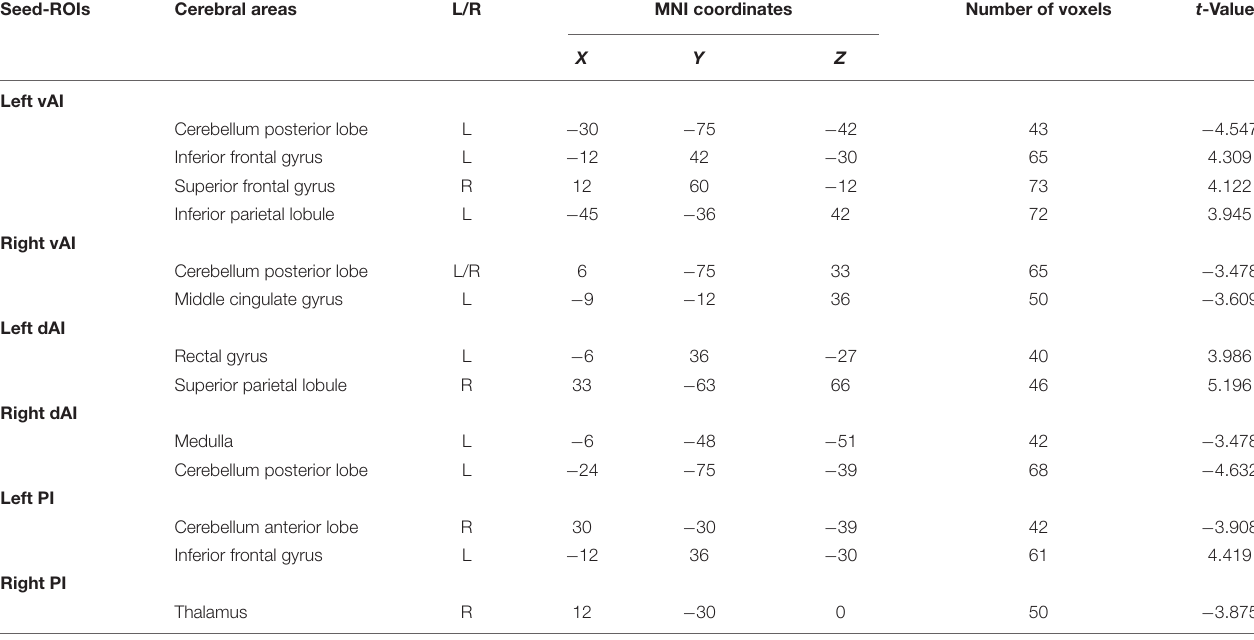
TABLE 2 | Cerebral areas showing functional connectivity differences with insular subdivisions between AMDs and HCs. Seed-ROIs Cerebral